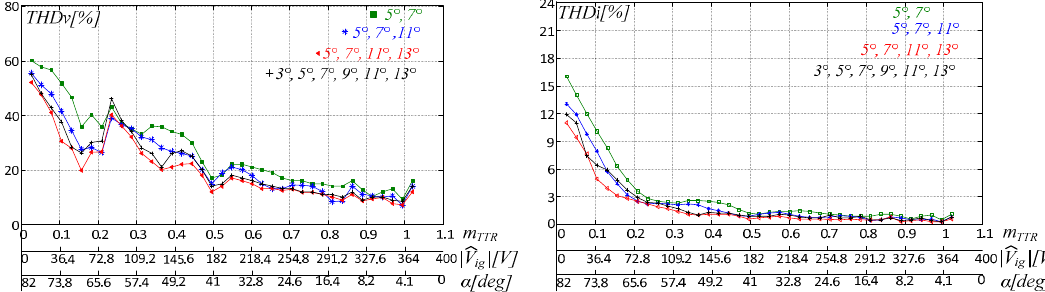
Figure 10. THDv and THDi vs. the peak amplitude of PMSG phase voltage.